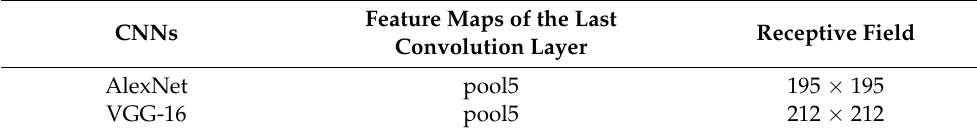
Table 1. The receptive fields of the last convolution layer of feature maps of AlexNet and VGG-16.